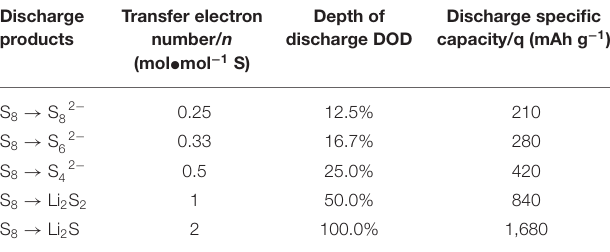
TABLE 1 | The relationship between DOD and the discharge specific